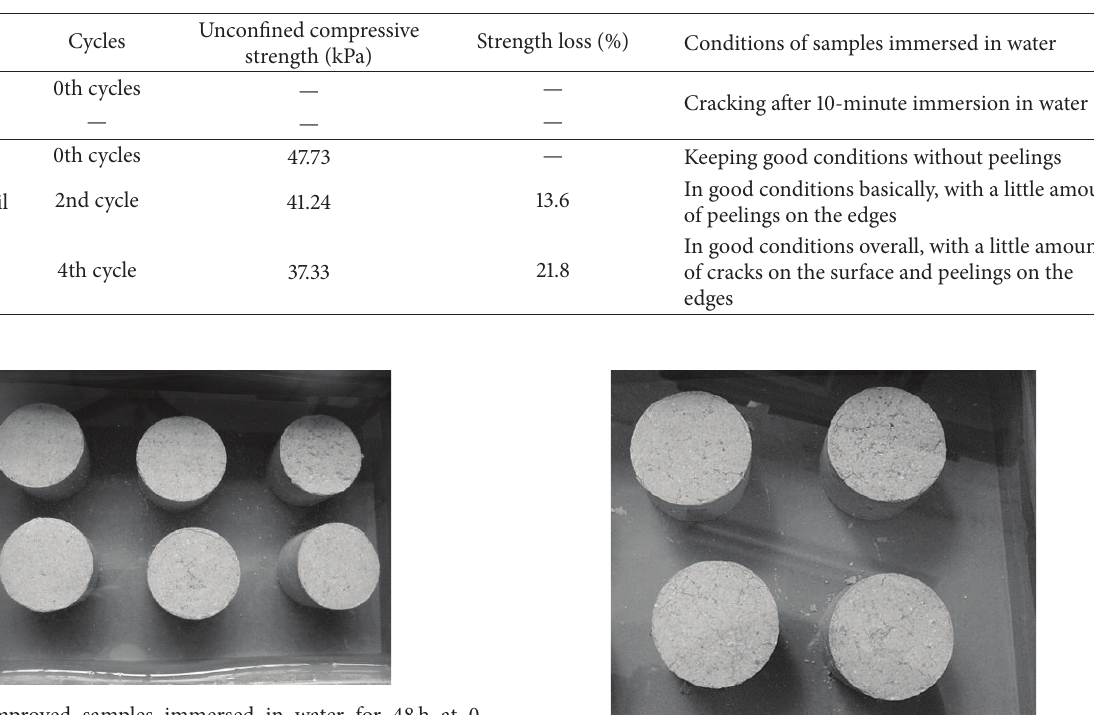
Table 5: Results of unconfined compressive strength during cyclic wetting-drying process.